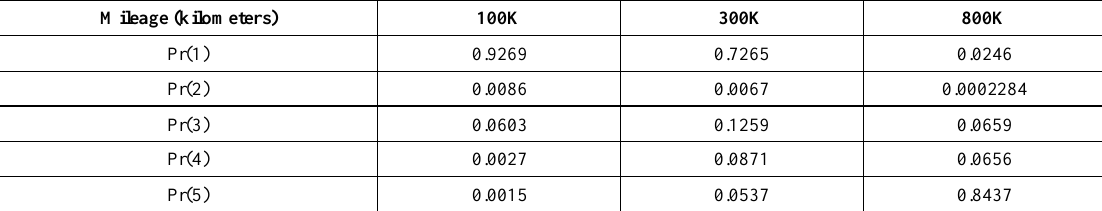
Table 4. System state probabilities with changing k.